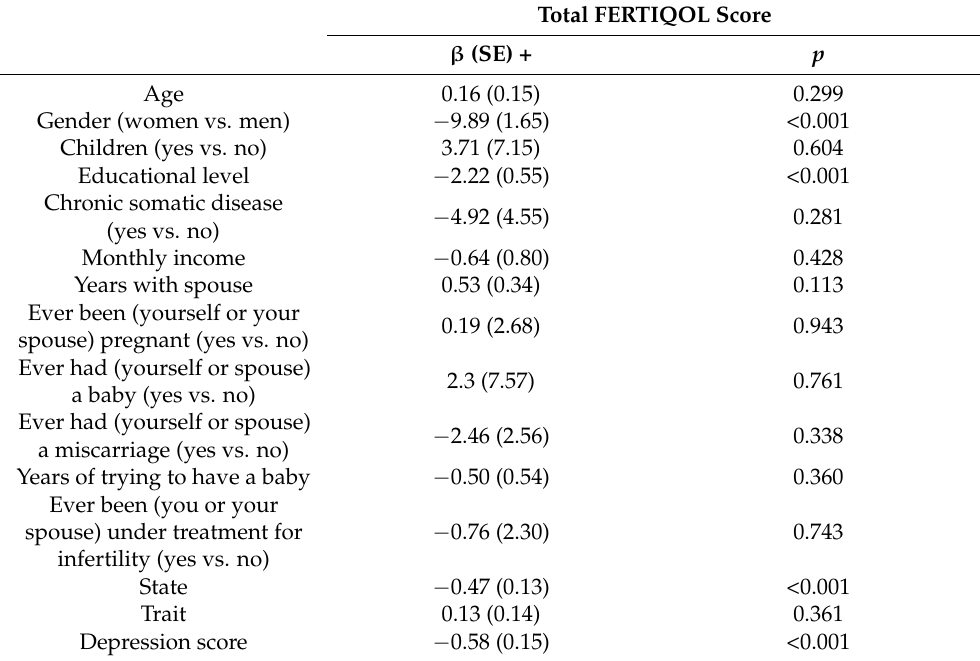
Table 5. Multiple linear regression results for overall FERTI-QoL